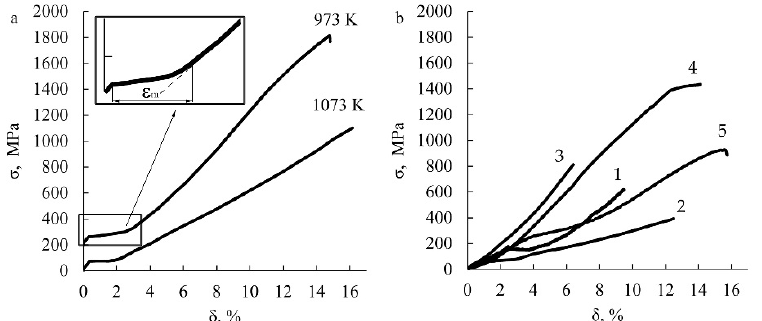
Figure 26. ( a ) «Stress–strain» (MPa) tensile curves under at RT of the Cu–14Al–4Ni alloy after MPC at temperatures 973 and 1073 K. ( b ) «Stress–strain» tensile curves under at RT of the Cu-14Al-3Ni alloy after different deformation-temperature treatments: (1) forging + quenching from 1223 K; (2) repeated quenching from 1273 K; (3) HPT, n = 10 revs, at 293 K; (4) HPT, n = 10 revs, at 423 K; (5) HPT, n = 10 revs, at 293 K + 1073 K, 10 s